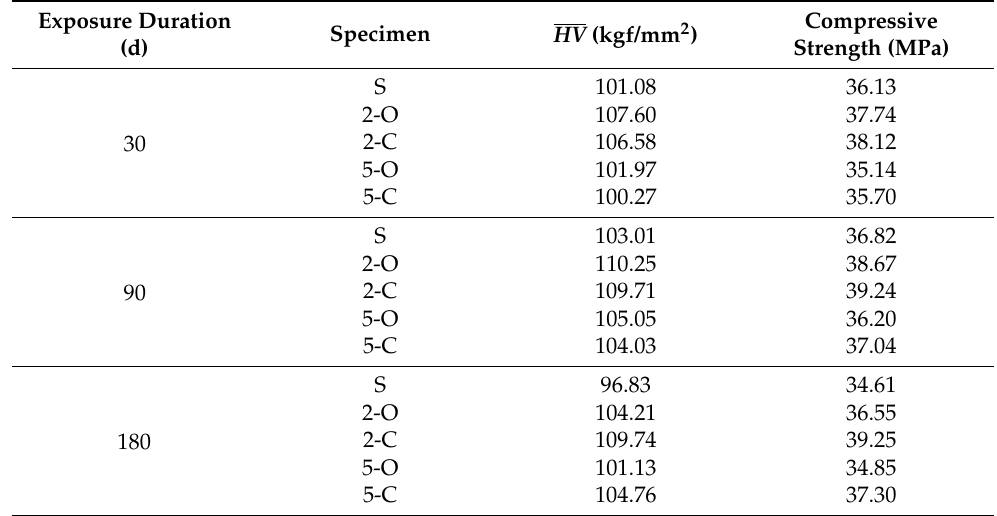
Table 4. Equivalent Vickers hardness and compressive strength of specimens under sulfate